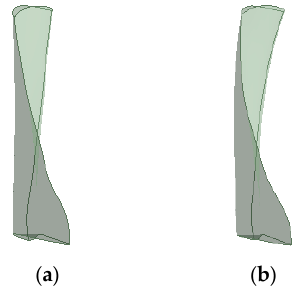
Figure 2. Diagram of blades. ( a ) original blade; ( b ) circumferentially forward ‐ skewed blade.